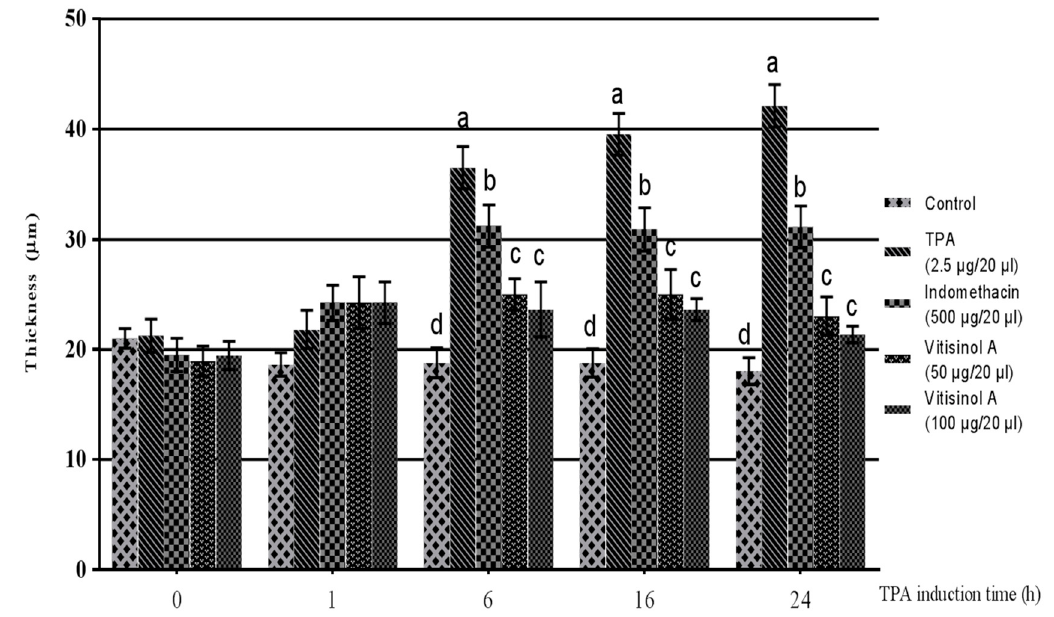
Figure 4. The anti-inflammatory effect of vitisinol A on 12- O -tetradecanoylphorbol 13-acetate (TPA)-induced ear edema of mice. The mice were divided into five groups: Control (without TPA and vitisinol A treatment), TPA (TPA-induced ear), Indomethacin (500 µ g of indomethacin on TPA-induced ear), and Vitisinol A (50 or 100 µ g of vitisinol A on TPA-induced ear). The experimental details are shown in Materials & Methods. Different letters indicate the significant difference between groups ( p < 0.05, Duncan test).